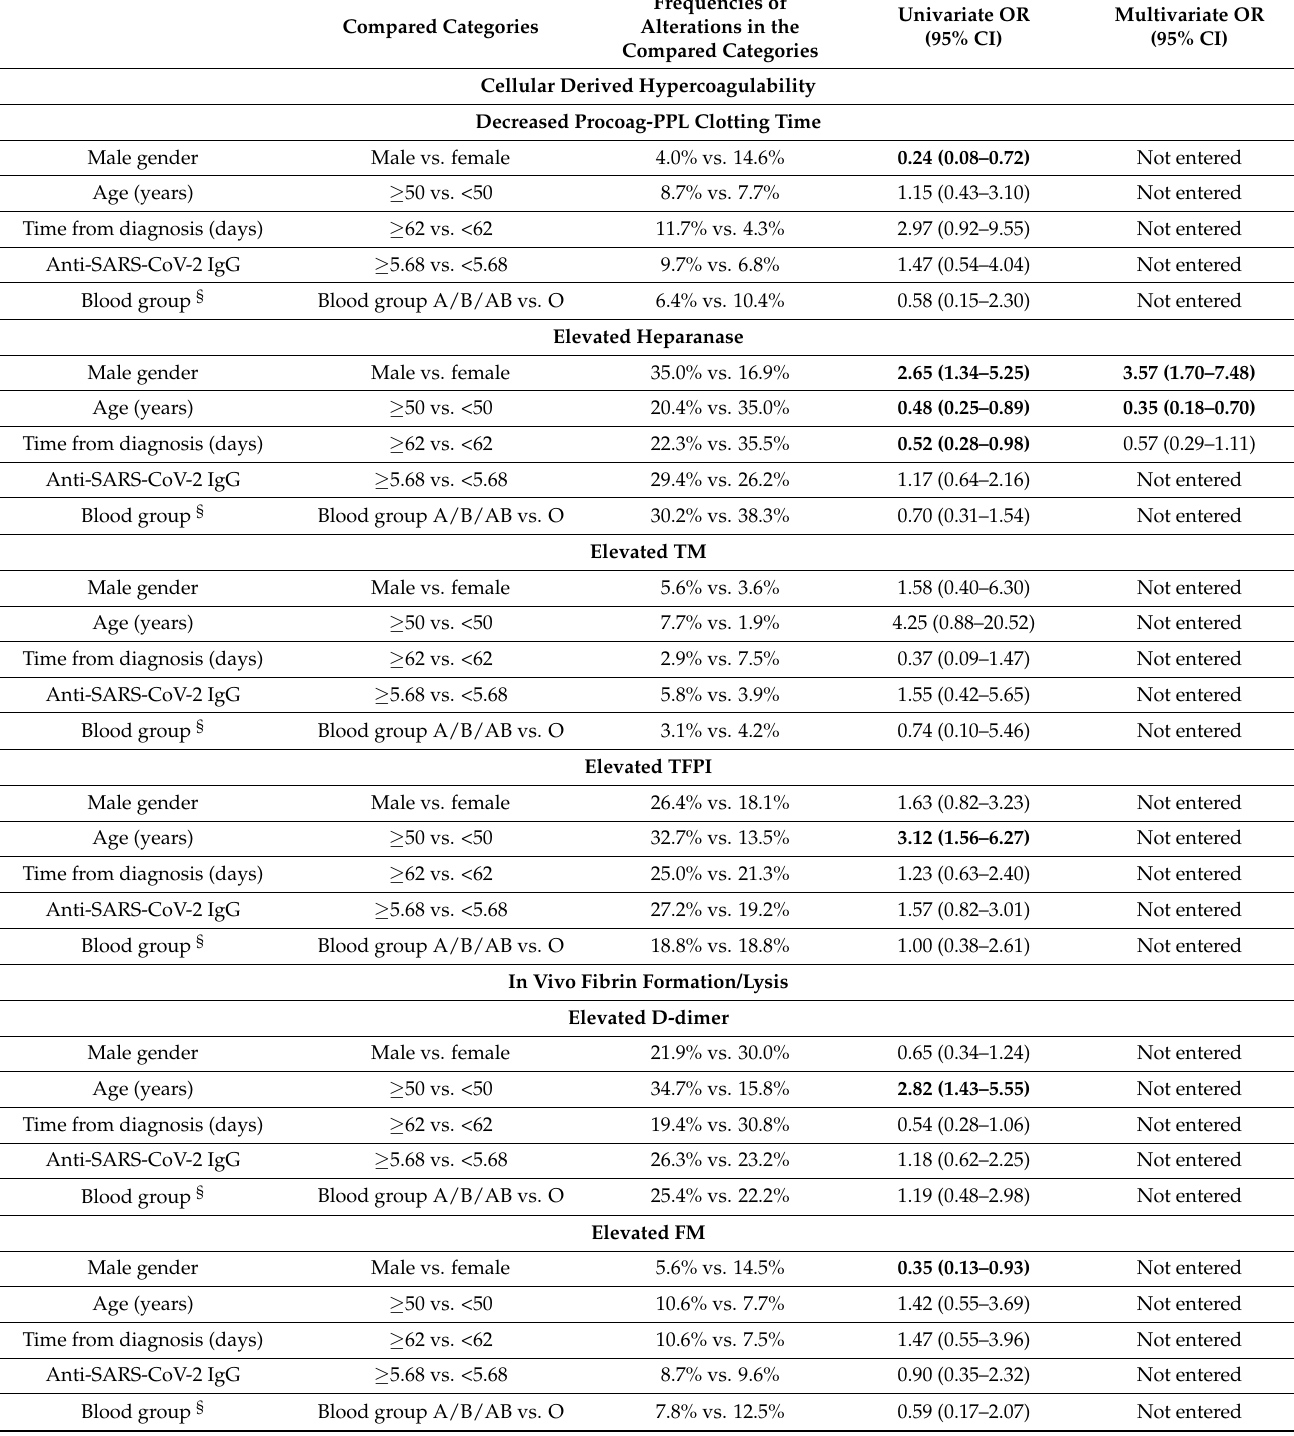
Table 3. Results of univariate and multivariate logistic regression analysis examining predictors of hypercoagulability in study cohort of COVID-19 survivors. Bold cells denote statistically significant associations ( p <